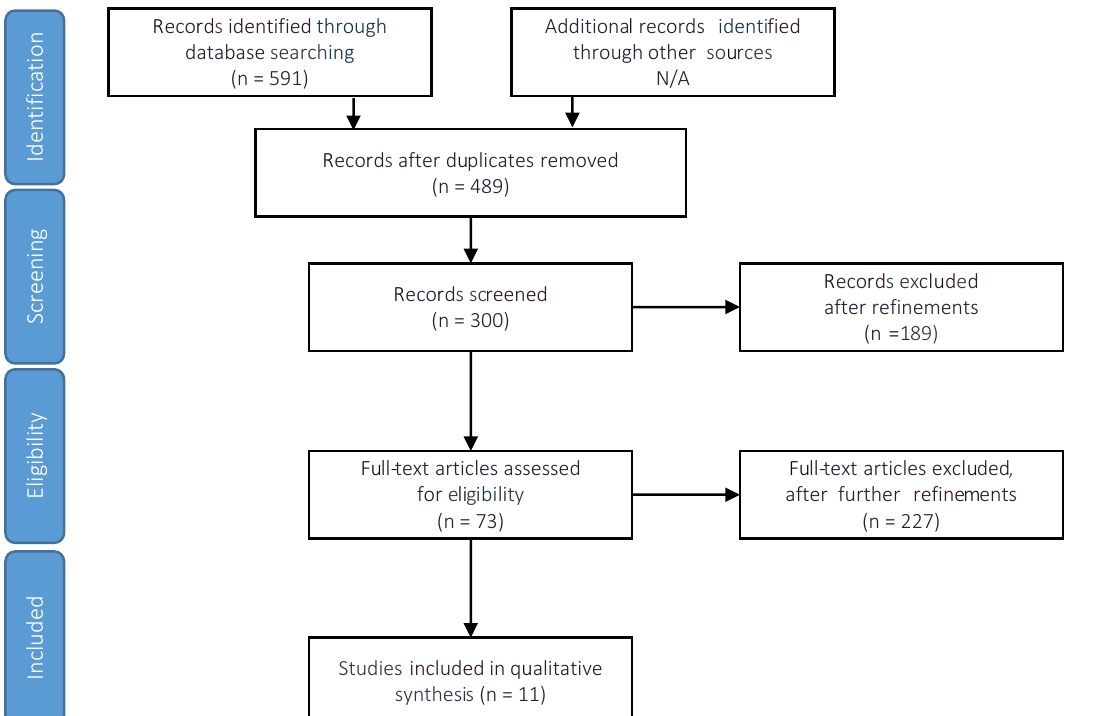
Figure 1. PRISMA flow diagram of literature